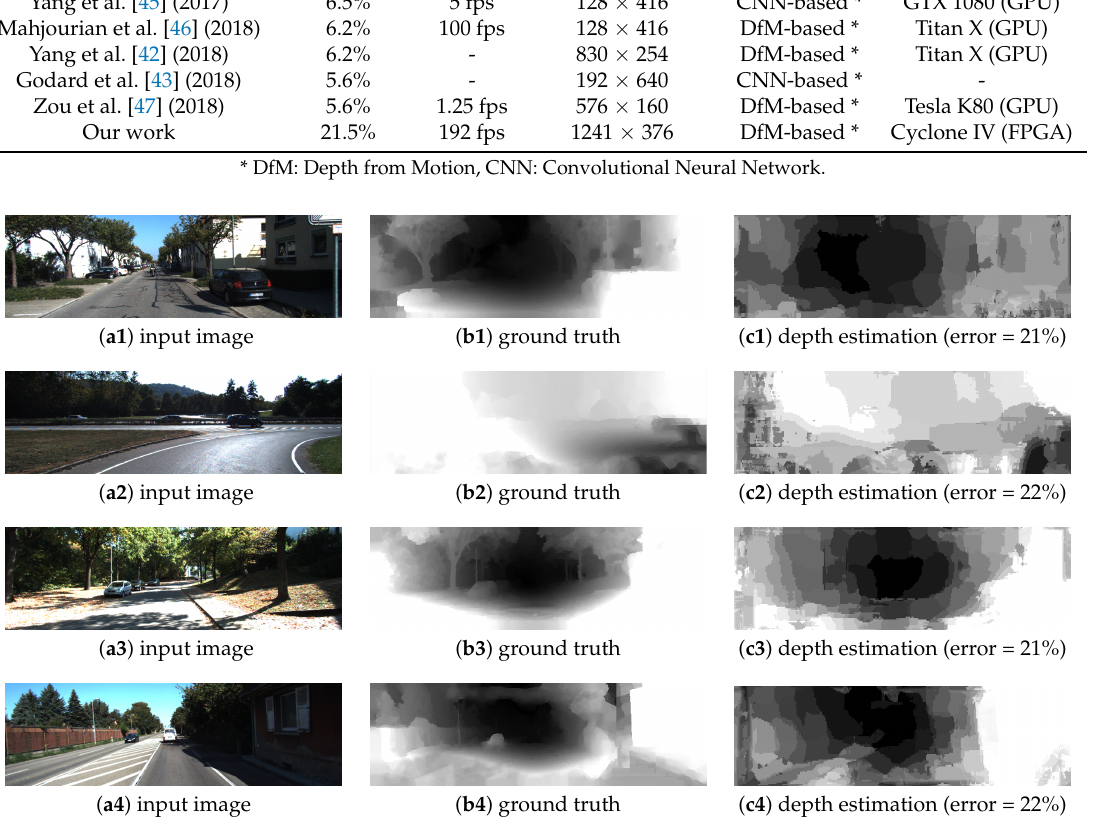
Figure 16. Depth estimation: quantitative/qualitative results for the KITTI